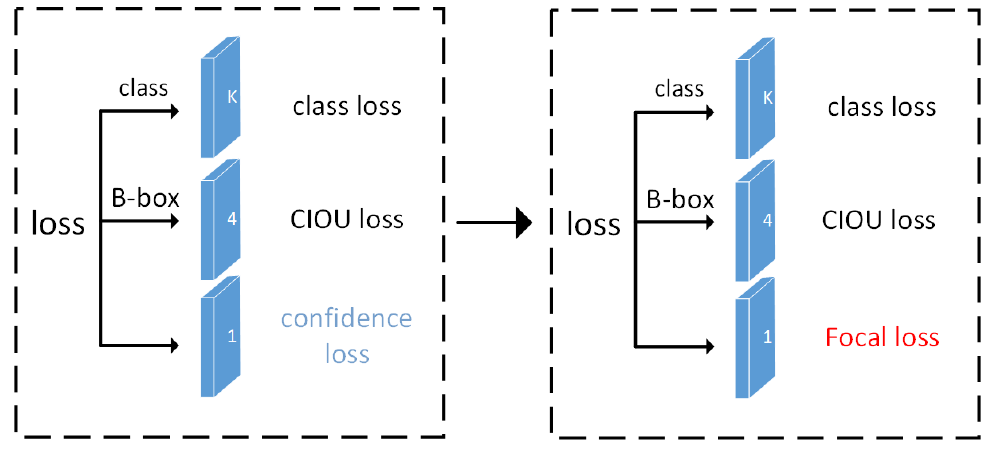
Figure 12. Focal loss function replaces the confidence loss function in